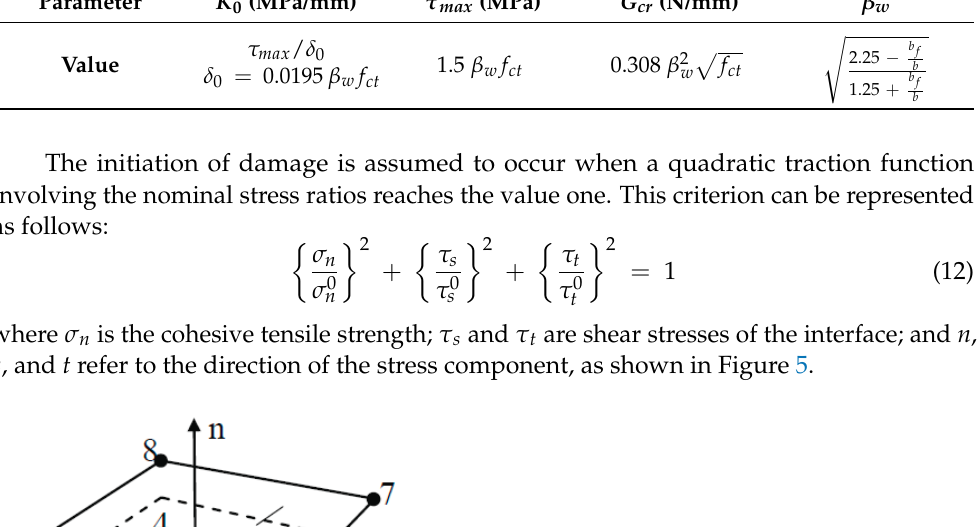
Figure 4. Bilinear bond-slip curve. Table 2. Parameters of bond-slip model used in the FE study.